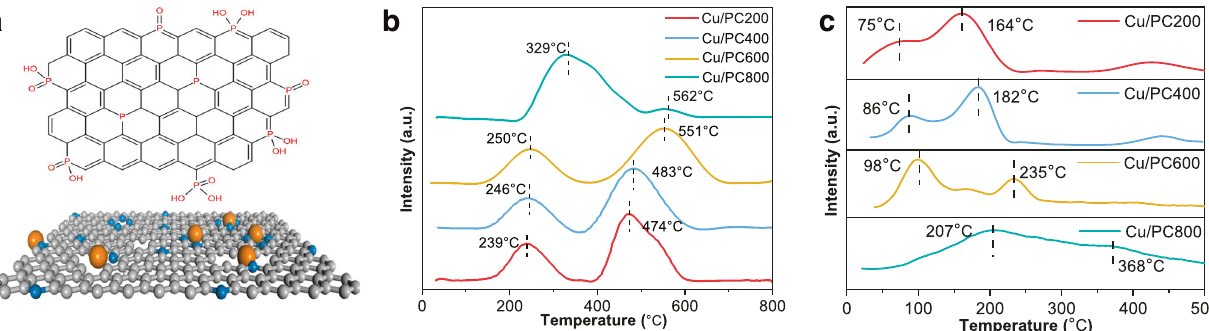
Fig. 5 Possible phosphorus-doped carbon substrates and adsorption and reduction properties of catalysts. a Possible structure for P species in fresh P-doped Cu-based catalysts. The gray (carrier), blue and orange balls representing P and Cu atoms, b TPR pro fi les of fresh P-doped Cu-based catalysts,